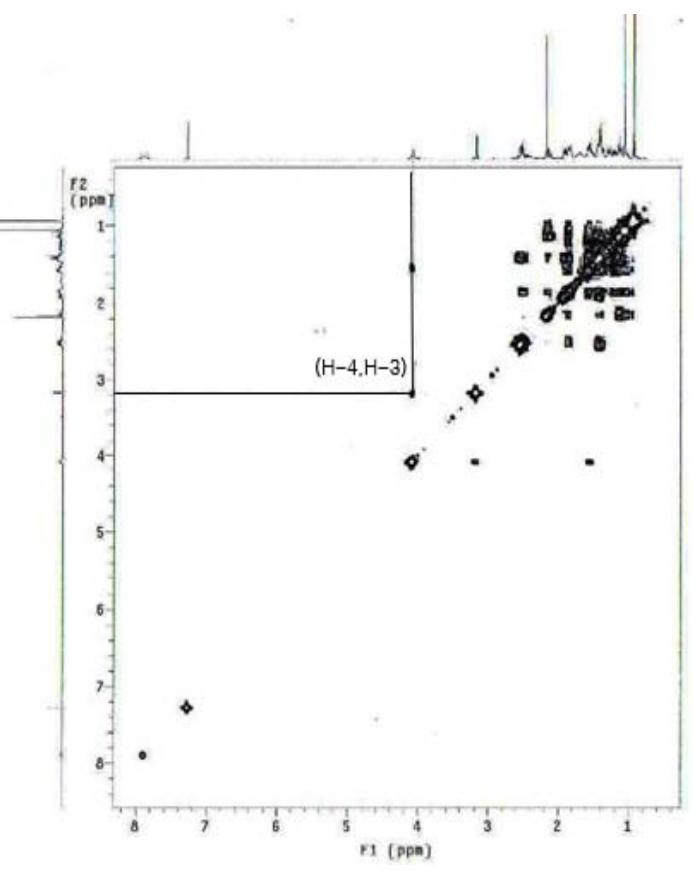
Figure 3. 1 H- 1 H COSY spectrum of 10 .